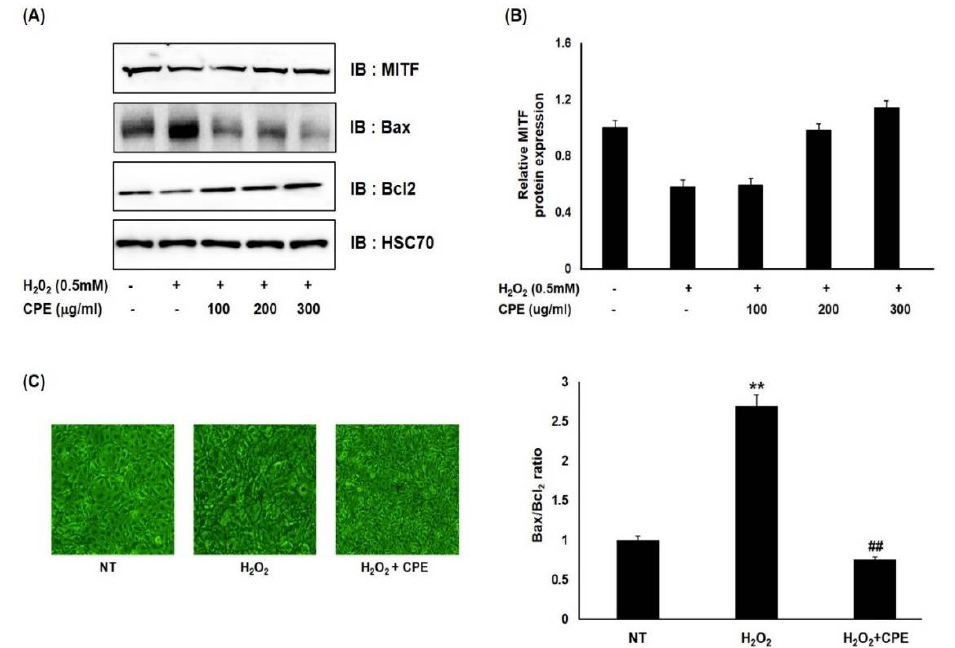
Figure 3. CPE protects melanocytes against oxidative-stress-induced cell damage. ( A ) Melan-a cells were first treated with CPE and then with H 2 O 2 for 24 h. The protein expression of MITF and Bcl2/Bax was measured by Western blot analysis, and HSC70 was used as an internal standard. ( B ) MITF and the Bax/Bcl2 ratio were calculated according to the areas of the expression bands. ( C ) The cell image was taken under a fluorescence microscope. All data are shown as the means ± SDs of at least three independent experiments (** p <0.01 vs. NT, ## p <0.01 vs. H 2 O 2 treated cells).